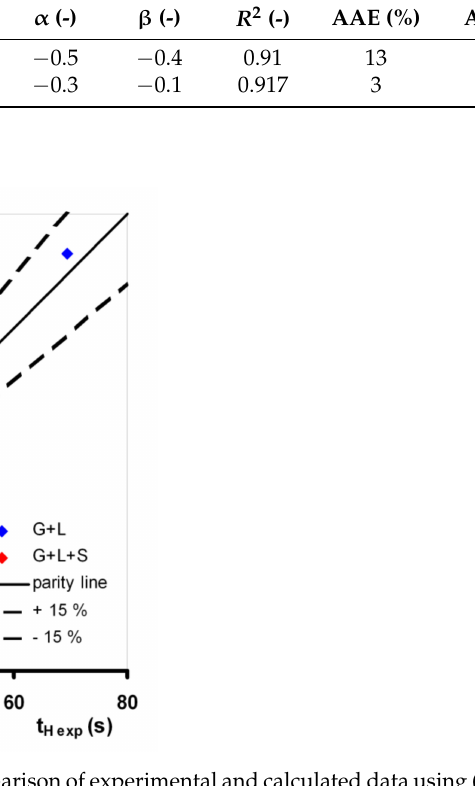
Figure 5. Homogenization time t H : Comparison of experimental and calculated data using (6)—parity plot.